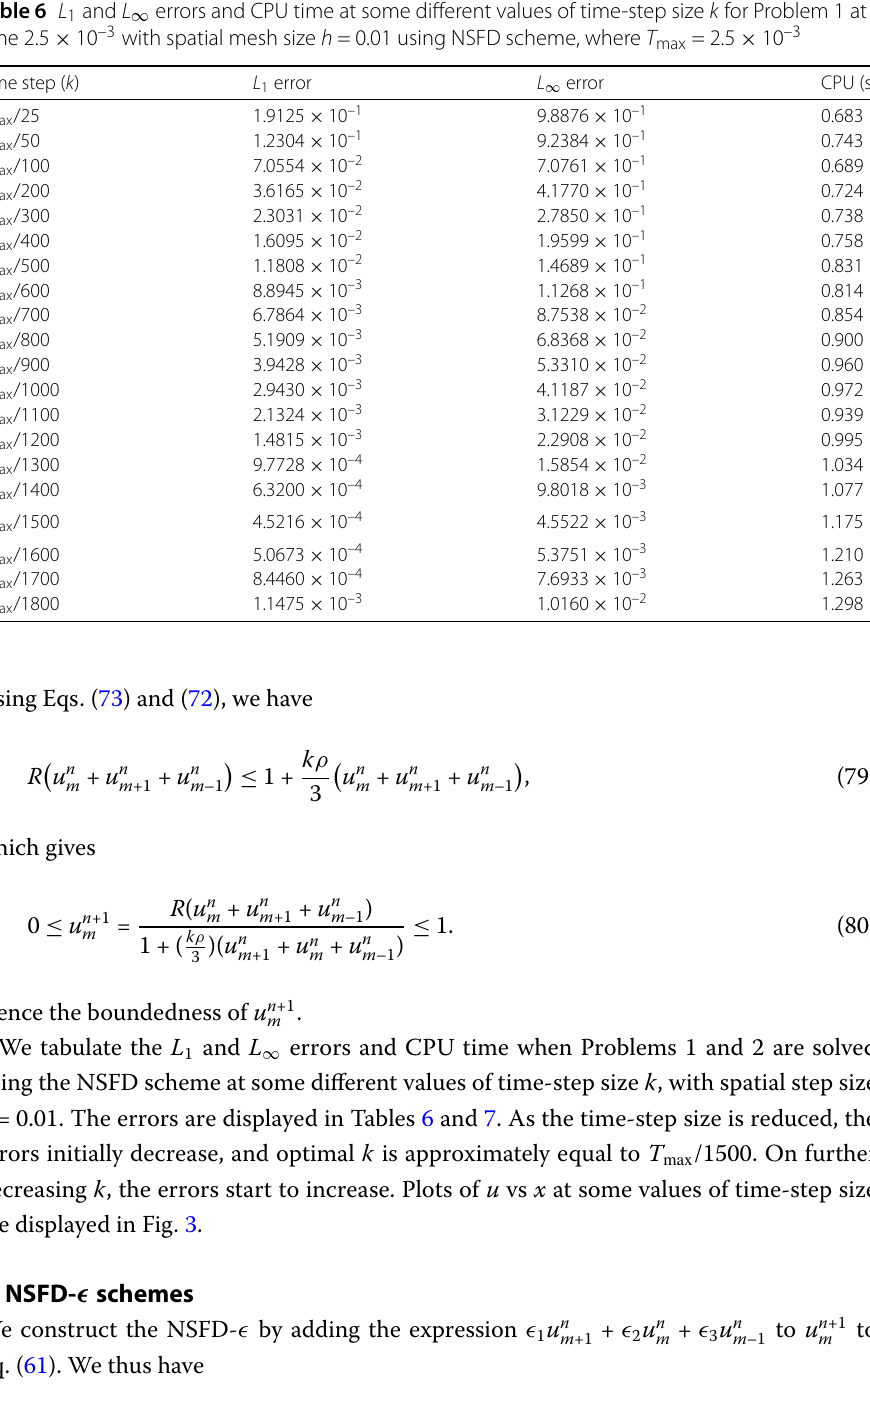
Table 6 L 1 and L ∞ errors and CPU time at some different values of time-step size k for Problem 1